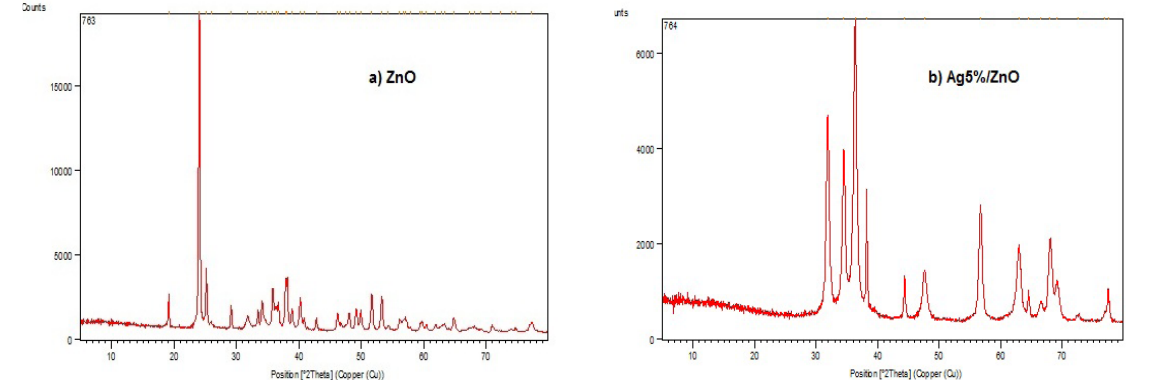
Figure 1. X-ray powder diffraction (XRD) spectra of nanoparticles synthesized Using sol-gel process (a) Zinc Oxide (ZnO); (b) Silver (Ag) 5%/ZnO Table 1. Mean crystallite size of synthesized nanoparticles, calculated by the debye-scherrer equation Nanoparticles